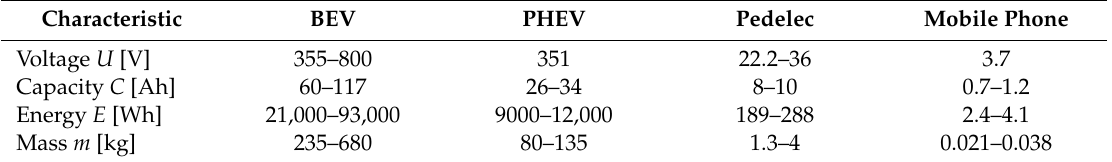
Table 1. Characteristics of lithium-ion batteries (LIBs) used in battery electric vehicles (BEVs), plug-in hybrid electric vehicles (PHEVs), electric bikes (pedelecs), and mobile phones [1,11,16,18].